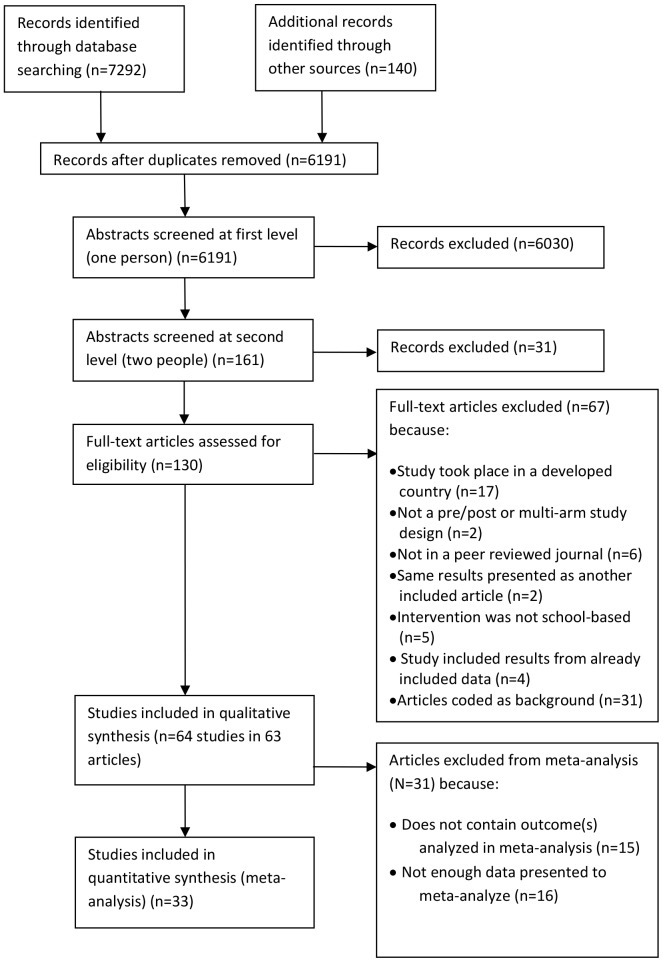
Disposition of citations during the search and screening process.